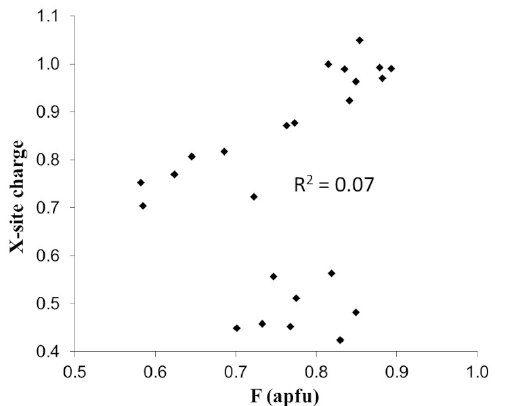
Figure 1. Correlation between the average X-site charge (Na 1 + , Ca 2 + , K 1 + , without Pb 2 + ) in Pb-rich tourmalines from the Minh Tien pegmatite, Luc Len district, Vietnam (samples from [33]).